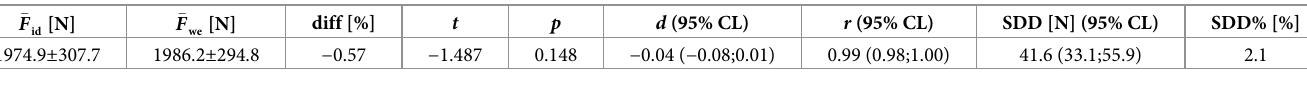
Table 1. Comparison between the mean vertical barbell force computed from an inverse dynamic versus the work-energy approach during snatch performance. � F [N] � F [N] id we